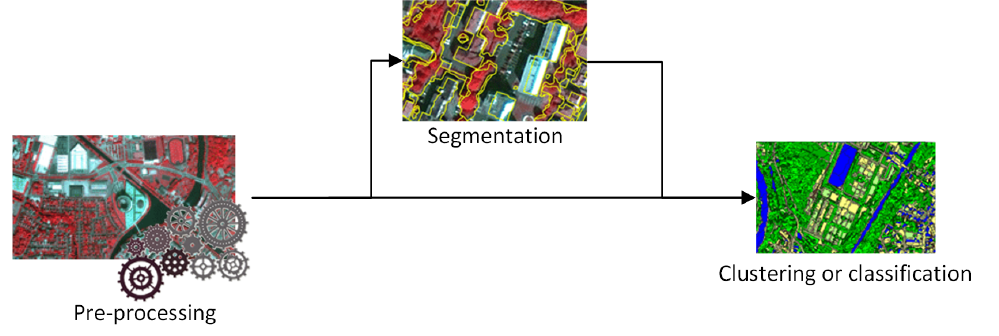
Figure 2. The 3 steps of satellite image